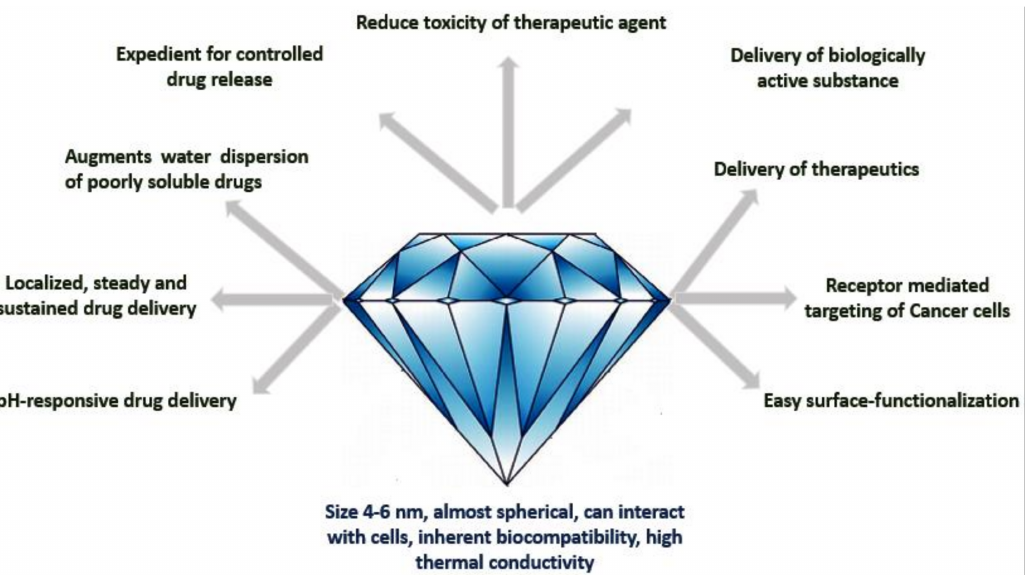
Figure 7. Applications and advantages of nanodiamonds. Adapted from